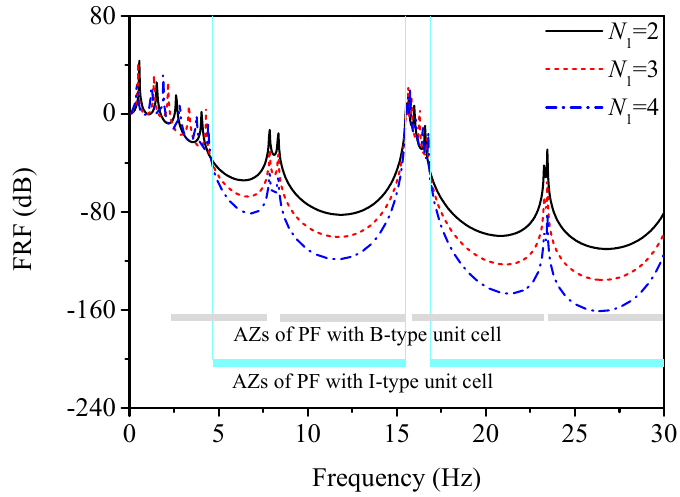
Figure 11. FRFs of the combined layered periodic foundation with various numbers of I–type unit cells and two II–type unit cells.